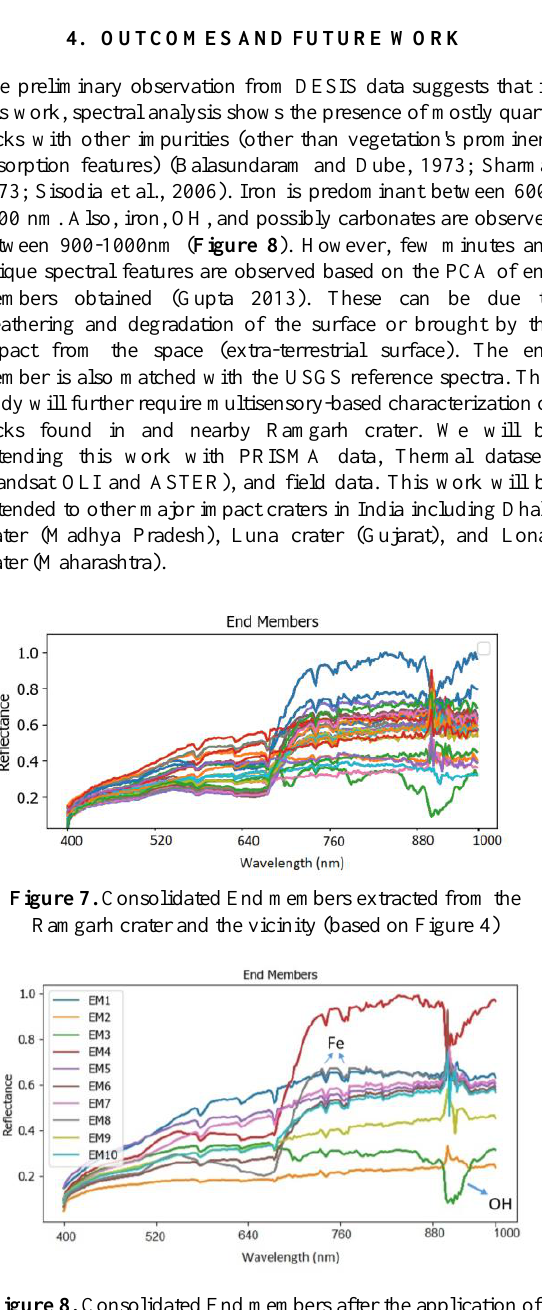
Figure 6. Google Images (Inside the crater)